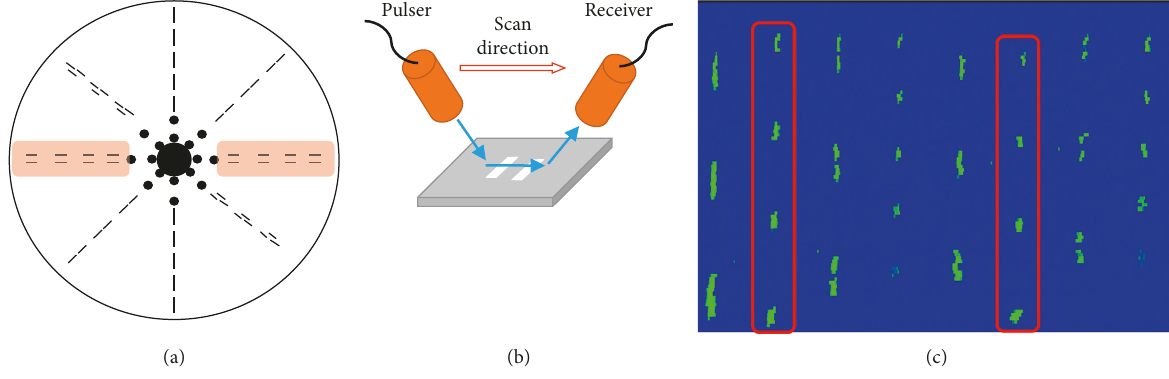
Figure 15: Experiment setup of H-double type crack: (a) crack location, (b) experiment, and (c) C-scan image.